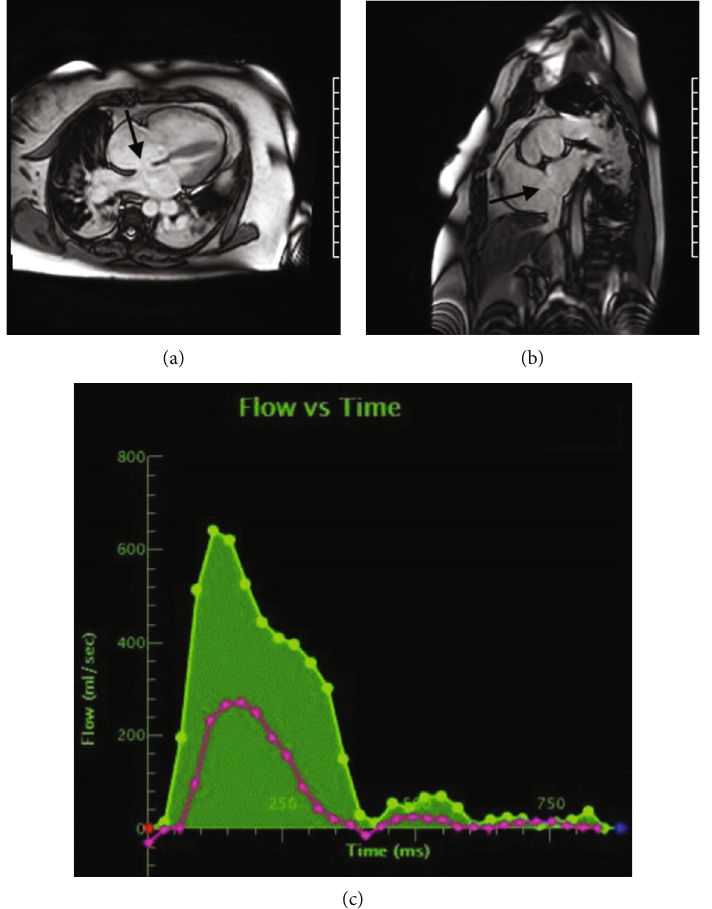
Figure 1: (a) CMR four-chamber view demonstrating dilated right heart with a 21 mm ASD (arrow). (b) CMR short-axis view demonstrating a 21 mm ASD (arrow). (c) CMR QP/QS of 2.9 (pulmonary fl ow in green and aortic fl ow in pink). ASD: atrial septal defect; CMR: cardiac magnetic resonance imaging; QP: right ventricular stroke volume; QS: left ventricular stroke